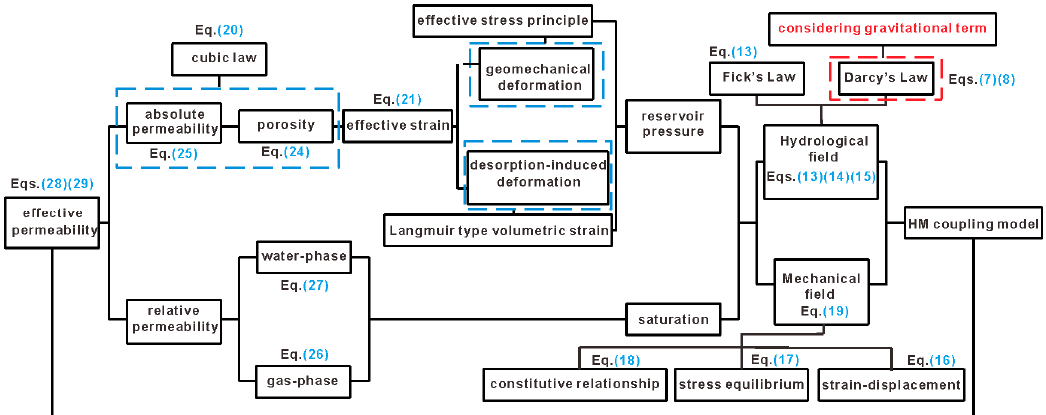
Figure A2. Interactions of multiple processes during CBM extraction.